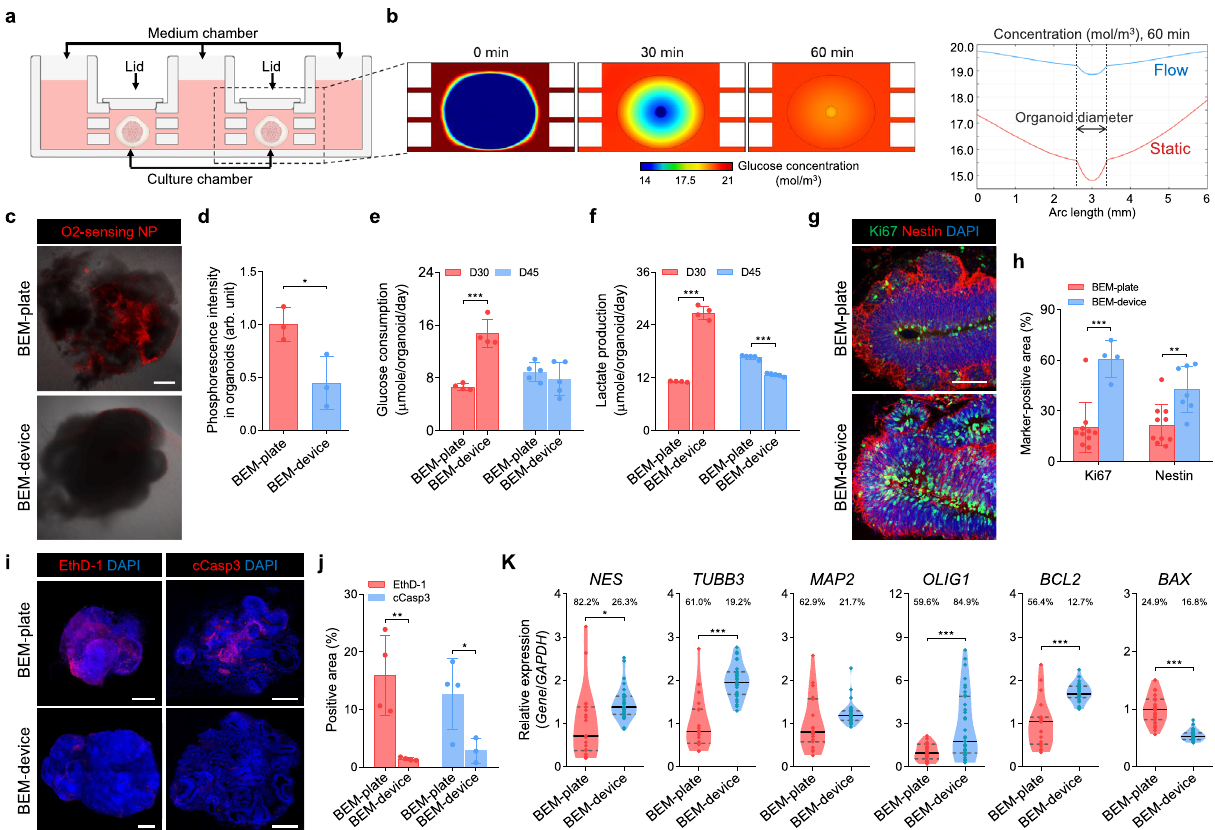
Fig. 5 Micro fl uidic dynamic culture supports the proliferation and prevents the apoptosis of brain organoids grown in the 3D BEM. a Schematic diagram of the micro fl uidic device for the brain organoid culture. b Computational simulation of glucose concentration within the brain organoid and its surroundings in a culture chamber under the fl uid fl ow conditions (left). Comparison of glucose concentration within the brain organoid in the presence and absence of fl uid fl ow (right). c Representative merged images showing organoids (gray) and phosphorescence of oxygen-sensing (PtTFPP-PUAN) nanoparticles at 754 nm (red) for BEM-plate (top) and BEM-device (bottom) organoids on day 30 (scale bars = 200 μ m, independent replicates = 4). d The normalized mean phosphorescence intensity in BEM-plate and BEM-device organoids ( n = 3 per group, BEM-plate versus BEM-device p = 0.032, independent replicates = 4). Measurement of ( e ) glucose level in organoids and ( f ) lactate level in the medium at days 30 and 45 ( n = 4 for D30 and n = 5 for D45, BEM-plate versus BEM-device p < 0.0001 at D30 and p < 0.0001 at D45, independent replicates = 2 for day 30 and 1 for day 45). g Immunostaining for the proliferation marker Ki67 and the progenitor marker Nestin in the BEM-plate and BEM-device organoids (scale bars = 50 μ m, independent replicates = 3). h The quanti fi cation analyses of Ki67 + and Nestin + cells in the BEM-plate and BEM-device organoids ( n = 10 for BEM-plate group, and n = 4 for Ki67 + and n = 7 for Nestin + in BEM-device group, BEM-plate versus BEM-device p = 0.0004 for Ki67 and p = 0.005 for Nestin, independent replicates = 3). i Brain organoids stained with ethidium homodimer-1 (EthD-1) to label dead cells at day 30 and cleaved caspase-3 (cCasp3) at day 45 (scale bars = 500 μ m). j Quanti fi cation of EthD-1 + and cCasp3 + area per organoid ( n = 4 for BEM-plate group, n = 4 for EthD-1 + and n = 3 for cCasp3 + in BEM-device group, BEM-plate versus BEM-device p = 0.0056 for EthD-1 and p = 0.049 for cCasp3, independent replicates = 3). k Differential gene expression analyses by qPCR with BEM-plate and BEM-device organoids. One sample was prepared from a single organoid. The coef fi cient of variations is dictated above the bars for each group. Data are expressed as violin plots. Dark gray dashed lines and black lines indicate 25 – 75% quartiles and median, respectively ( n = 19 for BEM-plate group and n = 30 for BEM-device group in all markers except for OLIG1 , n = 29 for BEM-plate group and n = 35 for BEM-device group in OLIG1 , BEM-plate versus BEM-device p = 0.0102 for NES, p < 0.0001 for TUBB3 , p = 0.0001 for OLIG1 , p < 0.0001 for BCL2 , and p < 0.0001 for BAX , independent replicates = 4). All analyses were performed over 30 days in the culture. All data are expressed as mean ± SD, otherwise stated separately. Statistical differences between the groups were determined by unpaired two-tailed t -test (* p < 0.05, ** p < 0.01, *** p < 0.001 versus BEM-plate grou p ). Source data are provided as a Source Data fi Importantly, the use of a micro fl uidic device reduced the downregulated in the BEM-device organoid. Additionally, the variability in the brain organoids grown in BEM hydrogel. The variation in gene expression in the BEM-device organoid was gene expression pro fi les of organoids in the BEM-plate and BEM- much less than that in the BEM-plate organoid — as indicated by device conditions were analyzed using a single organoid for each the lower variation coef fi cient value — with the exception of group (Fig. 5k). The relative expression of the neuronal markers, OLIG1 (Fig. 5k). The BEM organoids cultured in multi-well Nestin , TUBB3, MAP2 , and oligodendrocyte marker oligoden- micro fl uidic device designed to have 24 chambers for scalable drocyte transcription factor 1 ( OLIG1 ) was higher in the BEM- organoid culture (Supplementary Fig. 13a, b and Supplementary device organoid than that in the BEM-plate organoid. Relative to Video 3) not only displayed relatively higher expression of PAX6 the BEM-plate organoid, the expression of the anti-apoptotic and TUBB3 , but also showed signi fi cantly less variation in the marker B-cell lymphoma 2 ( BCL2 ) was upregulated, while that expression levels of both genes, compared to the BEM organoids of the apoptotic marker BCL2-associated X ( BAX ) was cultured using conventional plates (Supplementary Fig. 13c – f).